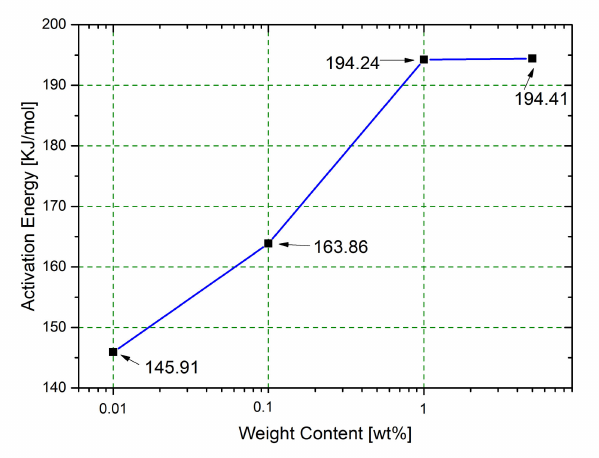
Figure 7. Degradation activation energies as function of nanocomposites filler